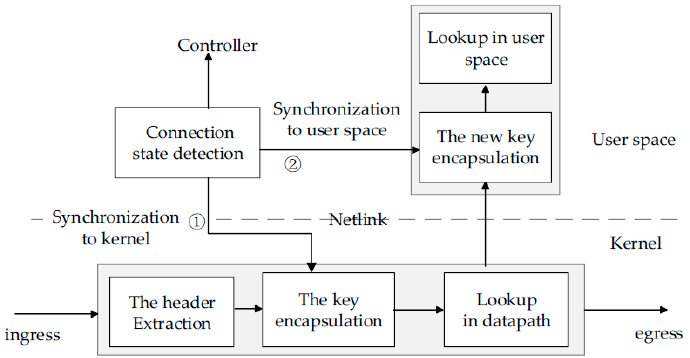
Figure 3. Synchronizing the real-time connection state to the kernel datapath and user space for encapsulating a lookup key. The key containing the connection state can match stateful rules.